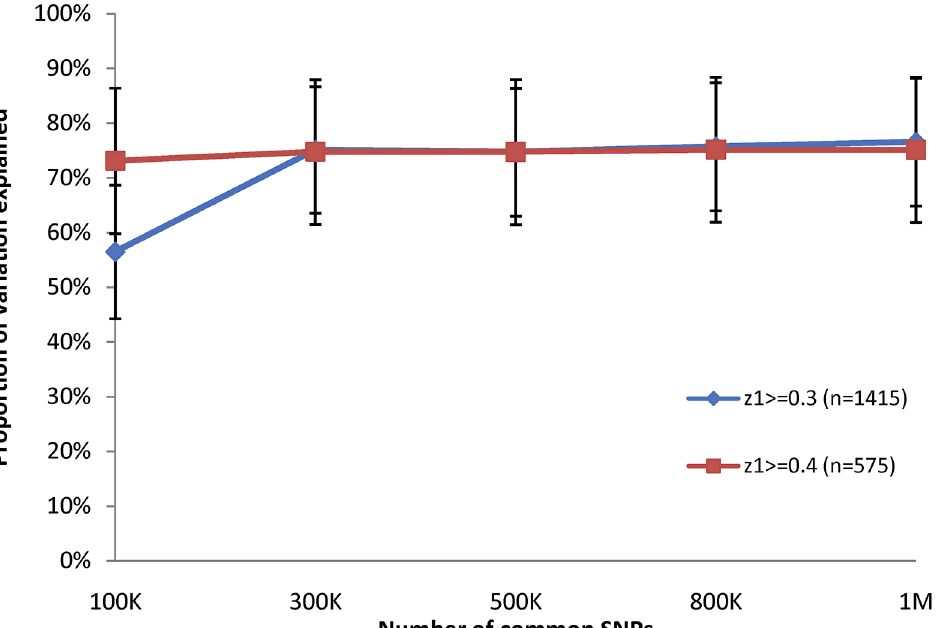
Fig 2. A comparison of phenotypic variation explained by different numbers of SNPs in close relatives. Variation of height explained by 10%, 30%, 50%, 80% and 100% of the nearly one million autosomal SNPs. Results are shown for two samples of related (z1 > = 0.3, blue line and z1 > = 0.4, red line) individuals.